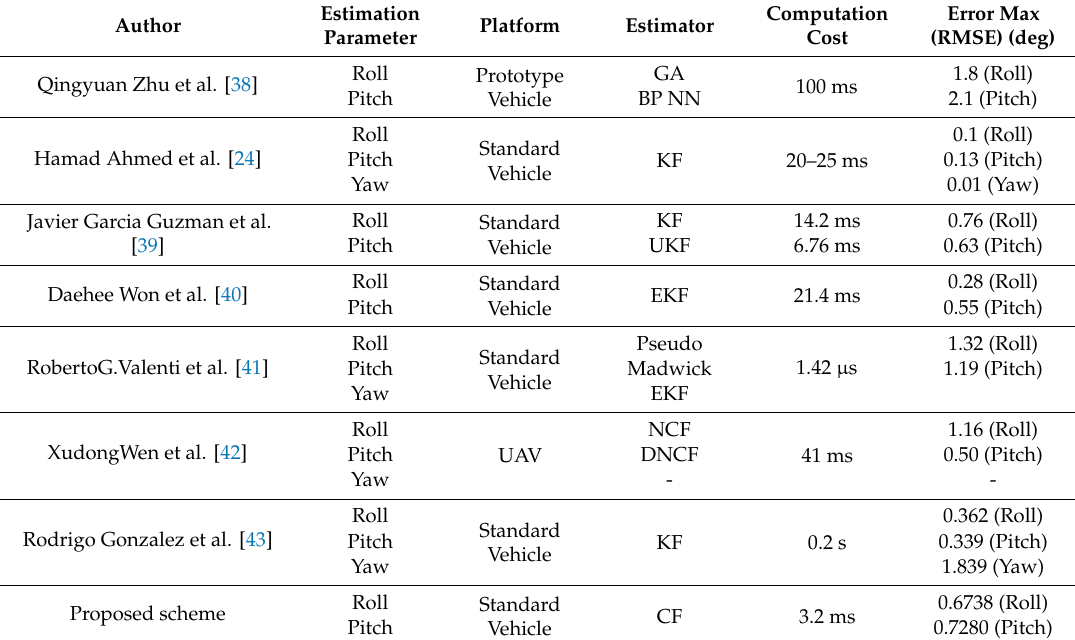
Table 3. RMSE comparison with current